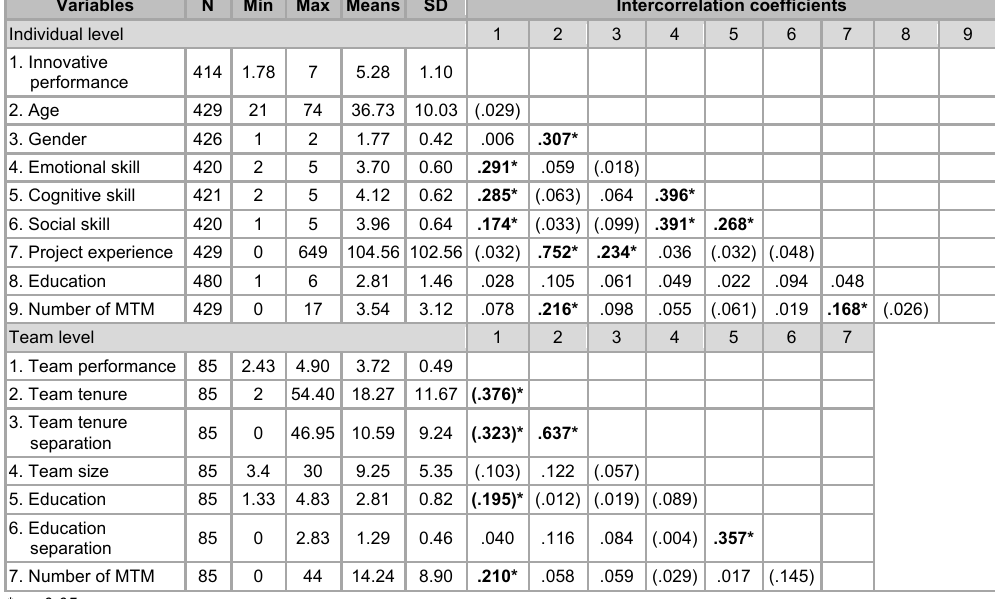
Descriptive data (means and standard deviations) and intercorrelation amongst the variables Variables N Min Max Means SD Intercorrelation